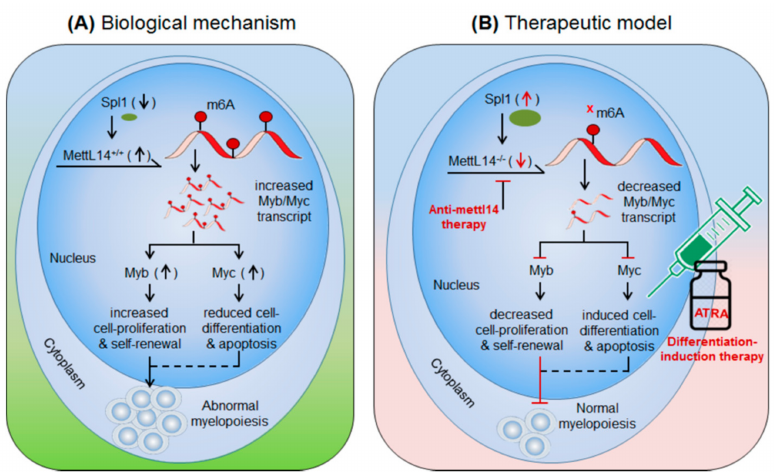
Figure 2. Therapeutic model targeting intracellular m6A-writer enzyme “Mettl14” in controlling AML. ( A ) Biological mechanism: Mettl14 methylates and enhances the expression of Myb and Myc transcription factor. The elevated MYB/MYC increases cell-proliferation and self-renewal capac- ity and reduces cell-differentiation and apoptotic processes, resulting in abnormal myelopoiesis. ( B ) Therapeutic model: Anti-Mettl14 therapy: intracellular silencing of Mettl14 decreases the expres- sion of Myb/Myc TcFs resulting in decreased cell-proliferation and improved cell-differentiation and apoptotic processes. Differentiation-induction therapy: all-trans retinoic acid (ATRA) further enhances cell-differentiation and apoptotic processes and thus allows normal myelopoiesis. Targeting other pathways like; Spl1, Myb/Myc, AKT pathways have been also proposed previously [62,63] in controlling